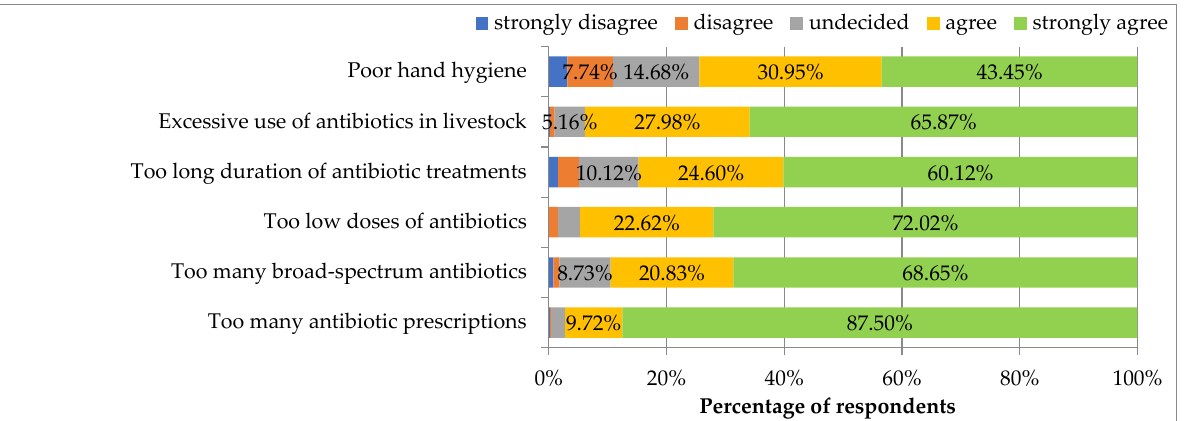
Figure 3. Importance of individual factors for the development of antibiotic resistance.